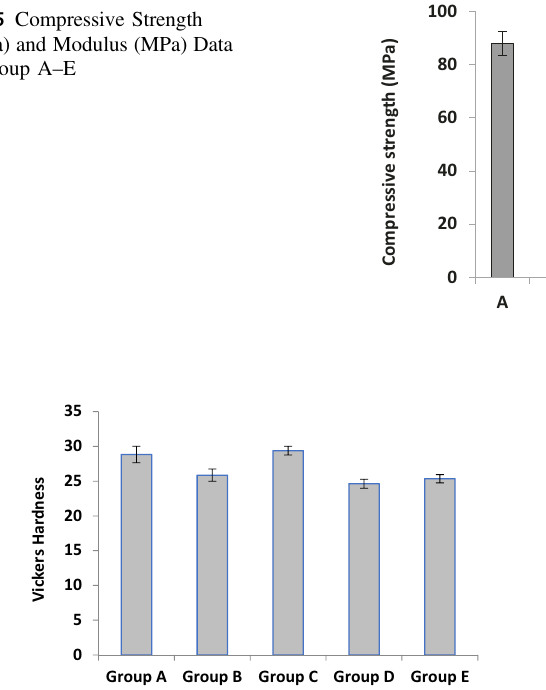
Fig. 6 Vickers Hardness (Kg/mm 2 ) Data of arti fi cial teeth